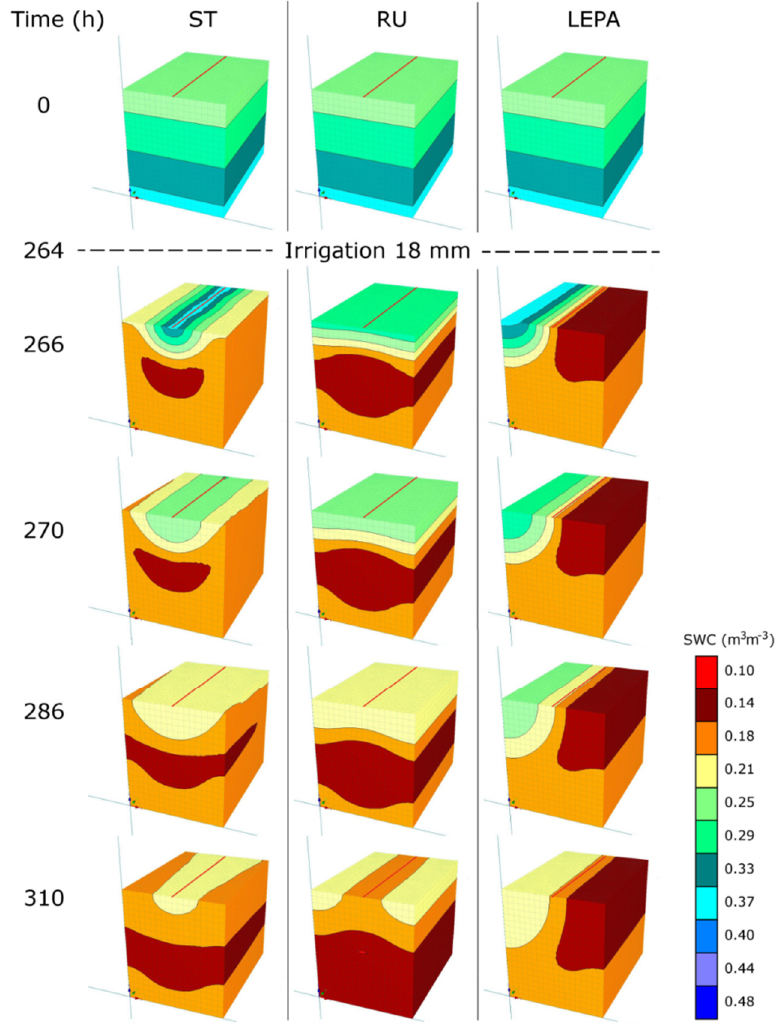
Figure 12. Visual 3D representation of soil water content (SWC, m 3 ·m − 3 ) in the 3D HYDRUS domain under deficit irrigation and characterized by: ST, stemflow/throughfall redistribution; RU, uniform rainfall application; LEPA, low-energy precision application system. The maize row is placed in the middle position of the soil domain (red